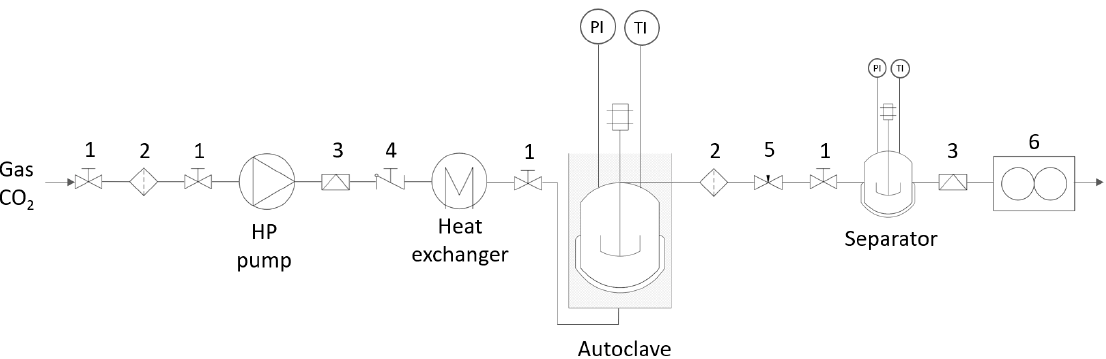
Figure 5. Schematic representation of the SFE process: 1 = valve, 2 = high pressure filter, 3 = rupture disc, 4 = one way valve, 5 = regulating valve and 6 = flowmeter [29].